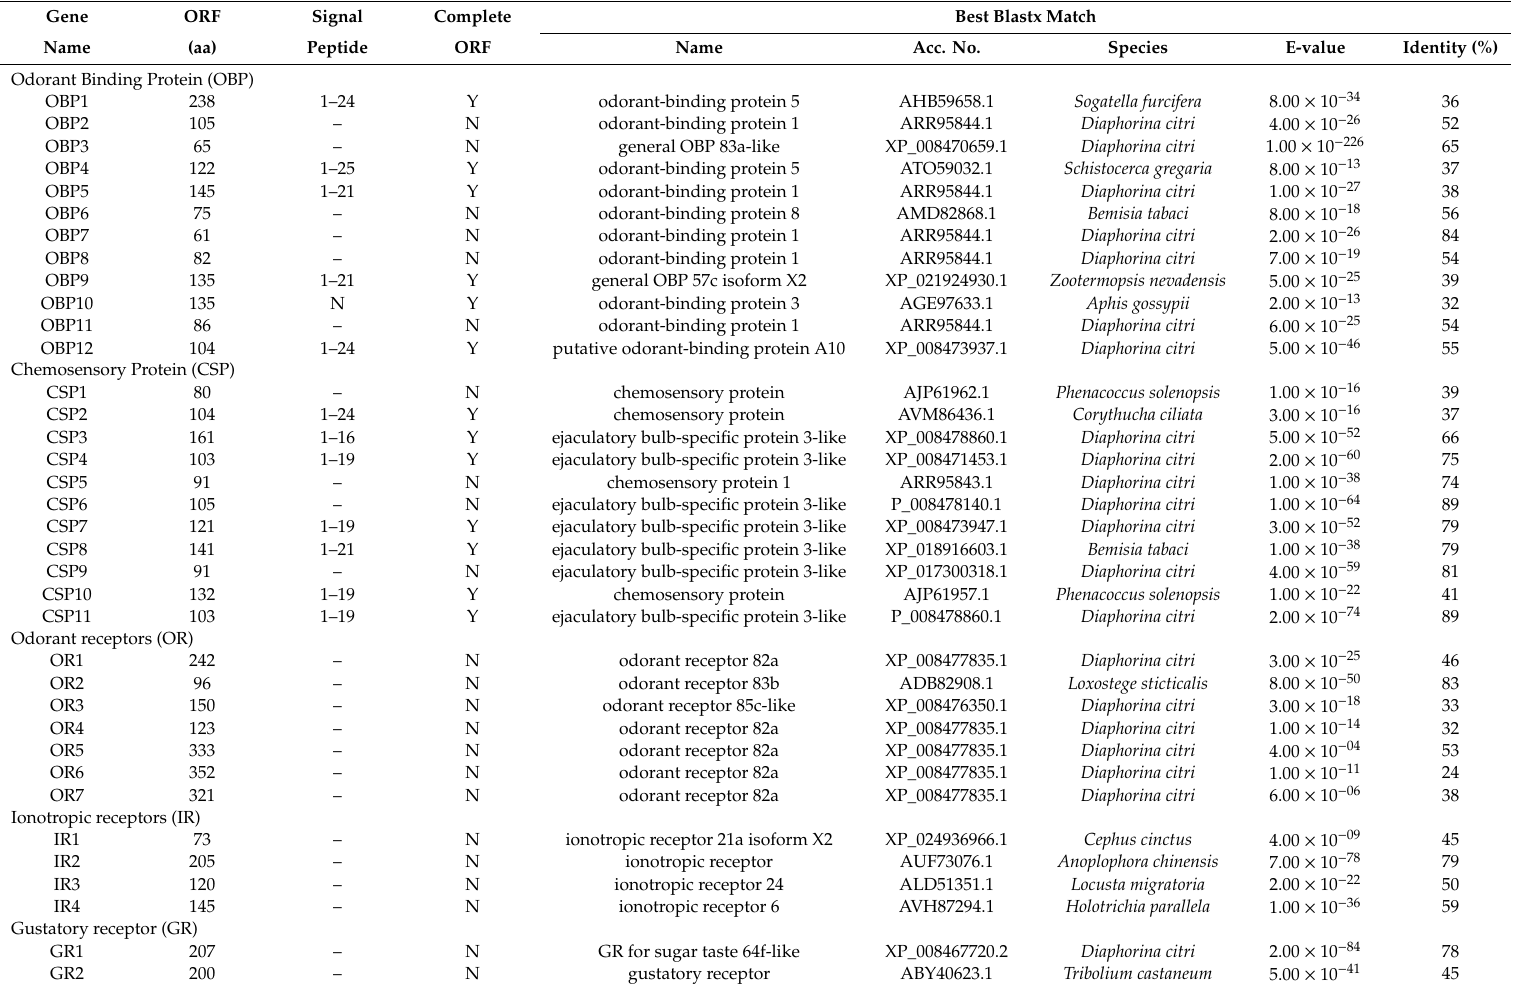
Table 2. The Blastx match of C. chinensis odorant binding protein (OBP) genes, chemosensory protein (CSP) genes, odorant receptor (OR) genes, ionotropic receptor (IR) genes, and gustatory receptor (GR) genes.